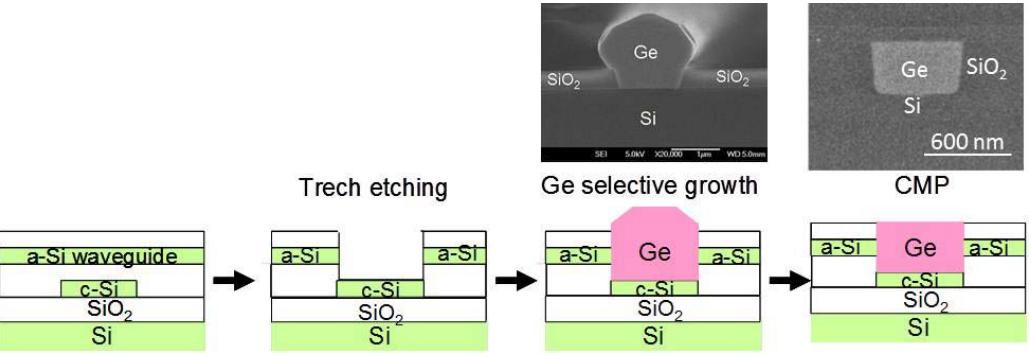
Figure 9. Schematic fabrication process of butt-coupled Ge PDs and EAMs on SOI platform. “a-Si” and “c-Si” refer to amorphous Si and crystalline Si, respectively. Trench-filling selective growth is applied to achieve these structures. Cross-sectional SEM pictures of trench-filled Ge selective growth and the Ge region after CMP are also shown. © 2006 IEEE. Reprinted, with permission, from